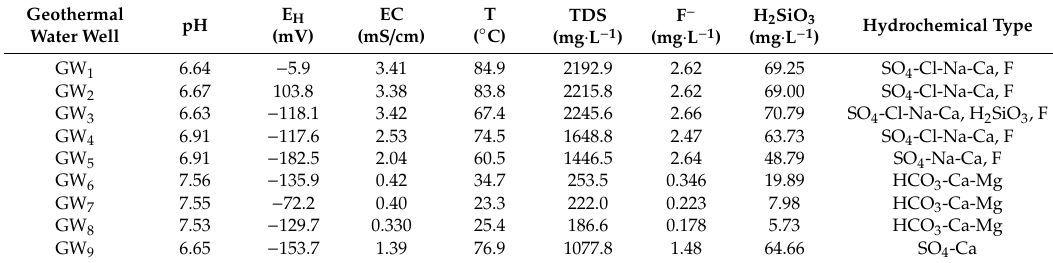
Table 1. Physicochemical characteristics of the analyzed geothermal water—results of the latest sampling